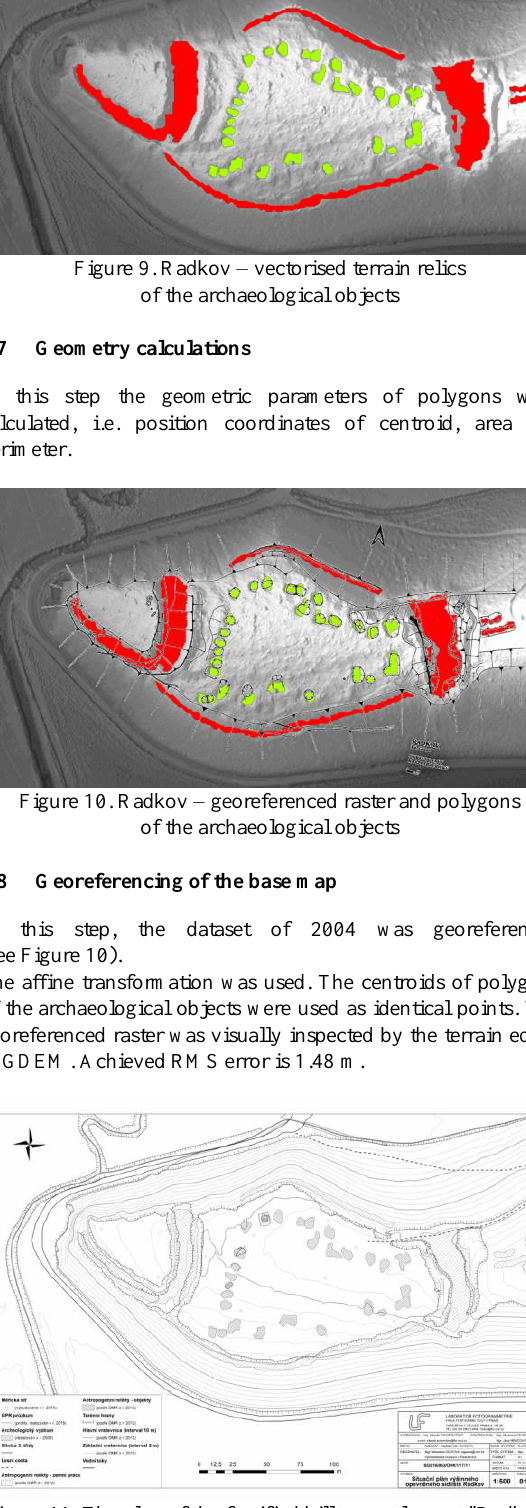
Figure 11. The plan of the fortified hilltop settlement